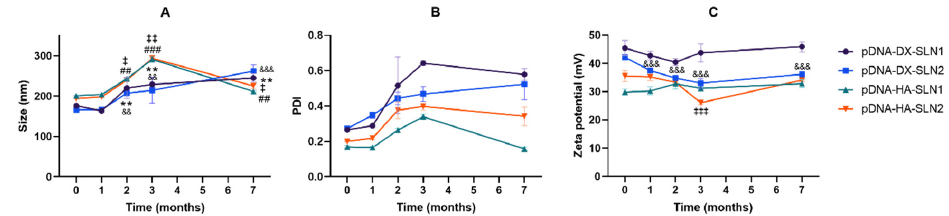
Figure 8. Size ( A ), polydispersity index ( B ) and ζ -potential ( C ) of pDNA-based vectors formulated with SLN1 and SLN2 at time zero and one, two and three months. Data are expressed as mean ± standard deviation; n = 3. ** p < 0.01 with respect to mRNA-DX-SLN1 at time zero. && p < 0.01, &&& p < 0.001 with respect to pDNA-DX-SLN2 at time zero. ## p < 0.01, ### p < 0.001 with respect to pDNA-HA-SLN1 at time zero. ‡ p < 0.05, ‡‡ p < 0.01, ‡‡‡ p < 0.001 with respect to pDNA-HA-SLN2 at time zero.